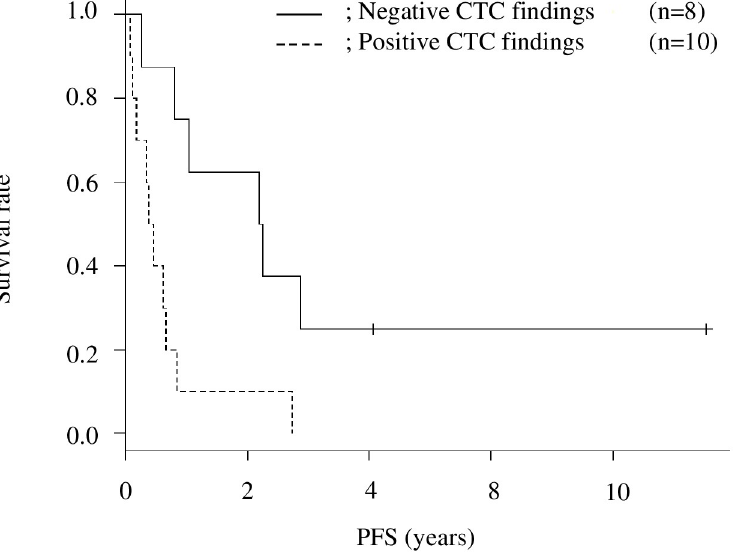
Fig 5. Kaplan–Meier survival curves for progression-free survival (PFS; clinical peritoneal metastasis-free period) after computed tomography colonography